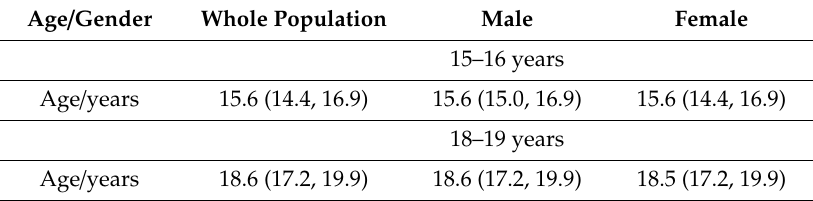
Table 1. Croatian physical activity in adolescence longitudinal study (CRO-PALS) study subjects according to age and